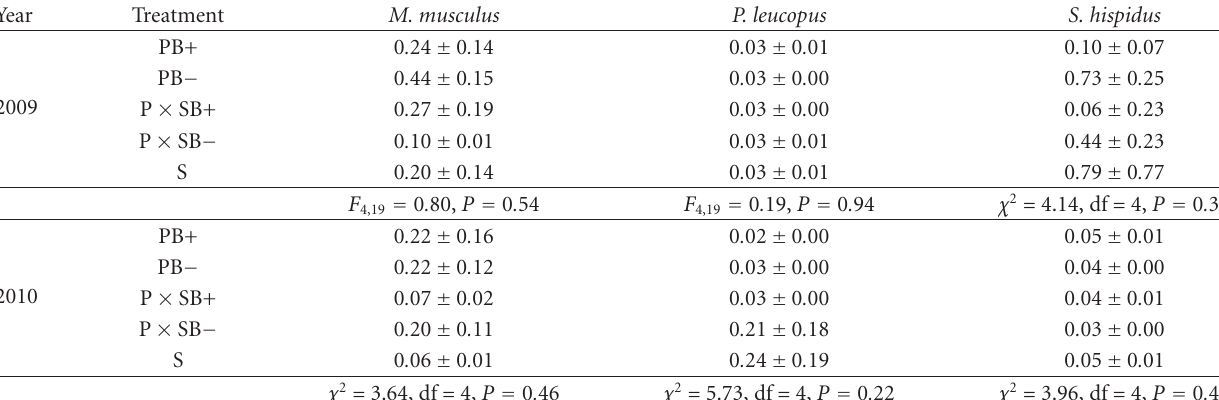
Table 2: Mean ( ± 1SE) recruitment estimates (new individual via birth or immigration/existing member/plot) by treatment (calculated in Program MARK). Rodents were captured and released on site at the Lenoir 1 Sustainability Study Site, in Lenoir Co., NC, during 15 July–9 December, 2009 and 19 July–14 November, 2010. Statistical results are from comparisons using a 1-way ANOVA or Kruskal-Wallis test when parametric assumptions were not met. Kruskal-Wallis test statistics are reported as χ 2 estimates. Treatments: PB+ = Pine Biomass+; PB − = Pine Biomass − ; P × SB+ = Pine × Switchgrass Biomass+; P × SB − = Pine × Switchgrass Biomass − ; S = Switchgrass.